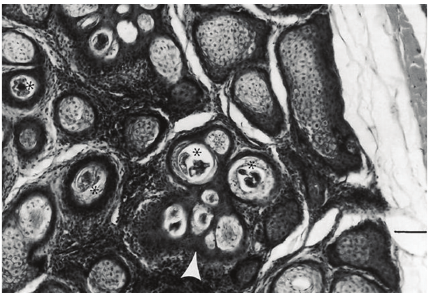
Figure 9: Section from an infected meibomian gland, showing D. ghanensis mites (asterisks) in the glandular acini, granulomatous reactions in the infected acini, and proliferation of connective tissue surrounding the granulomas (white arrow head). Haematoxylin and Eosin. Scale bar: 200 𝜇